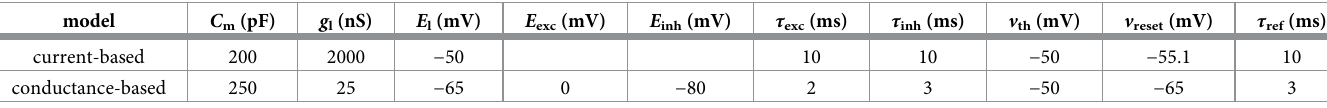
lent to the current-based case. The neuron parameters are given in Table 1. Table 1. Neuron parameters.